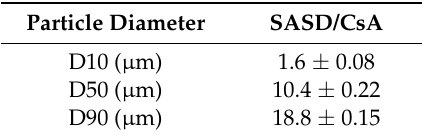
Table 1. Particle size distribution of cyclosporine A (CsA) in spherical amorphous solid dispersion formulation based on Poly-αβ-CD copolymers. Each measurement was carried out in triplicate.